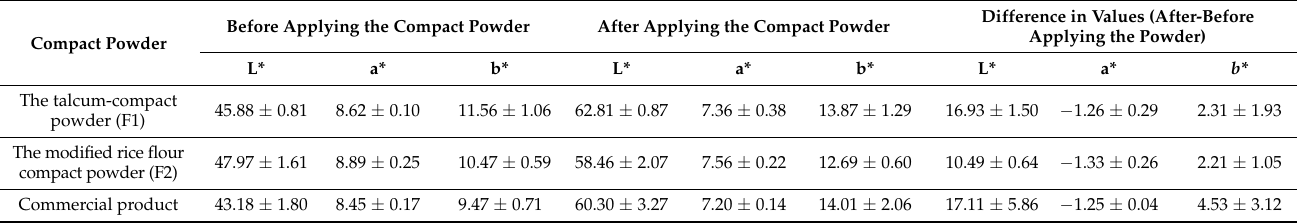
Table 2. Mean of color values (color’s lightness (L*), red/green intensity (a*), yellow/blue intensity (b*)), before and after applying the compact powders, and the difference.